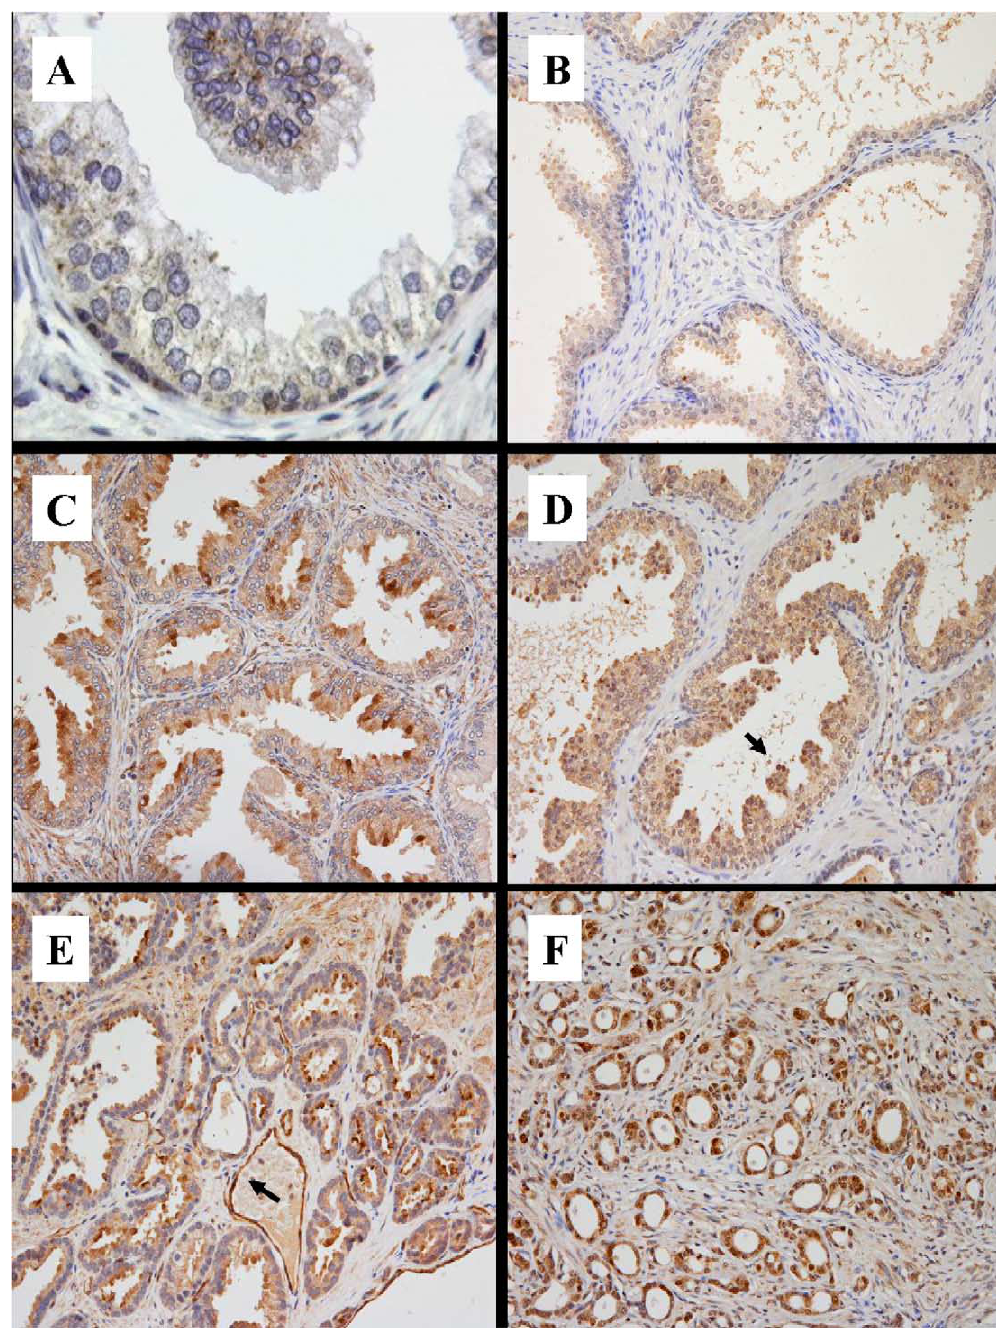
Fig. 1. Immunostaining for the SSTR subtype 4. Faint staining (1 + ) in the cytoplasm of the basal and to a less extent in the secretory cells in the untreated (A) and androgen ablated normal looking epithelium (B). Moderate (2 + ) to strong (3 + ) staining in the cytoplasm and to a less extent in the membrane of untreated (C) and androgen ablated (D) HGPIN. Stromal and endothelial staining is seen in C whereas nuclear staining in the secretory cells is seen in D (arrow). Moderate (2 + ) to strong (3 + ) staining in the cytoplasm and to a less extent in the membrane of untreated (E) and androgen ablated (F) PCa. Strong endothelial staining is seen in E